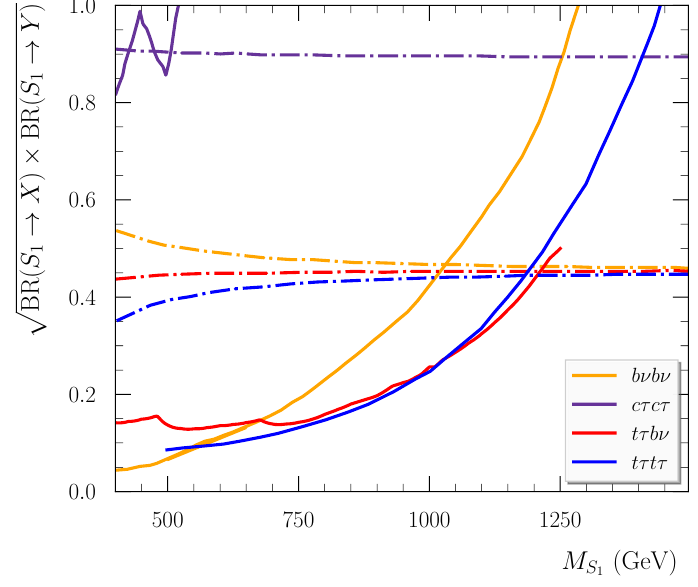
Figure 7 . Sensitivity of the considered LHC searches for leptoquark pair production and decay into third generation fermions. We present as solid lines the branching ratio reach as a function of the leptoquark mass for the tτtτ (blue), bνbν (orange), and cτcτ (purple) channels, as well as for the mixed mode in the tτbν final state (red). We show through dashed lines the branching ratios corresponding to our benchmark points BS1 (for the cτcτ channel) and BS2 (for the three other channels). For the mixed decay the dashed line represents the geometric mean of BR( S 1 → tτ ) and BR( S 1 → bν )